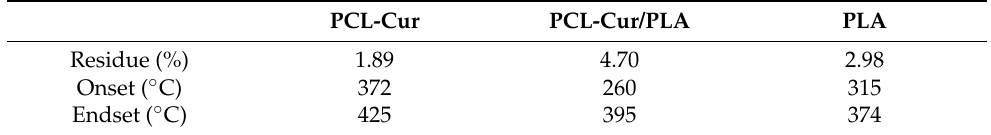
Table 1. Onset temperatures, endset temperatures and residue contents of electrospun membranes.